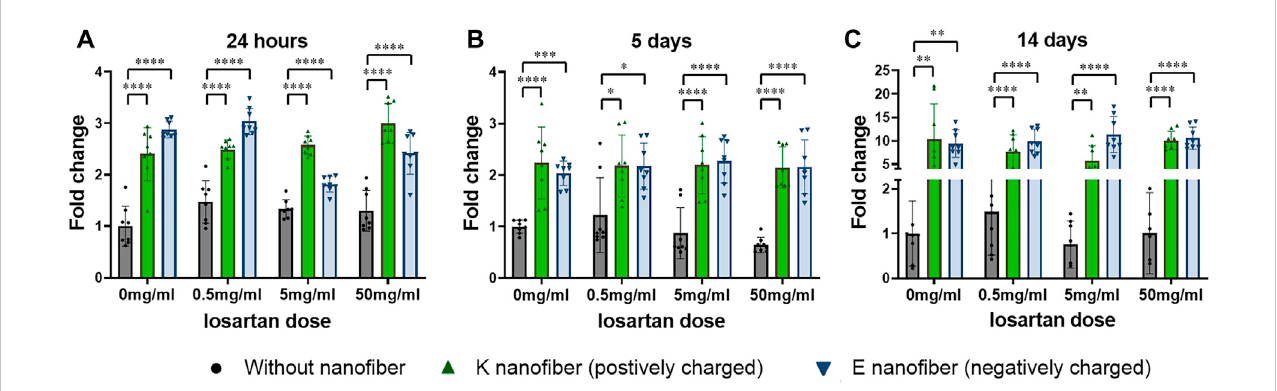
FIGURE 5 Nano fi berspromotecellproliferationinalosartan-independentfashion.Cellproliferationwassigni fi cantlyincreasedinboththepositivelychargedKand negatively charged E nano fi bers at all losartan doses after (A) 24 h, (B) 5 days, or (C) 14 days of treatment. C (black); without nano fi ber, ▲ (green); K nano fi ber (positively charged), and ▼ (blue); E nano fi bers (negatively charged). N = 8 per each